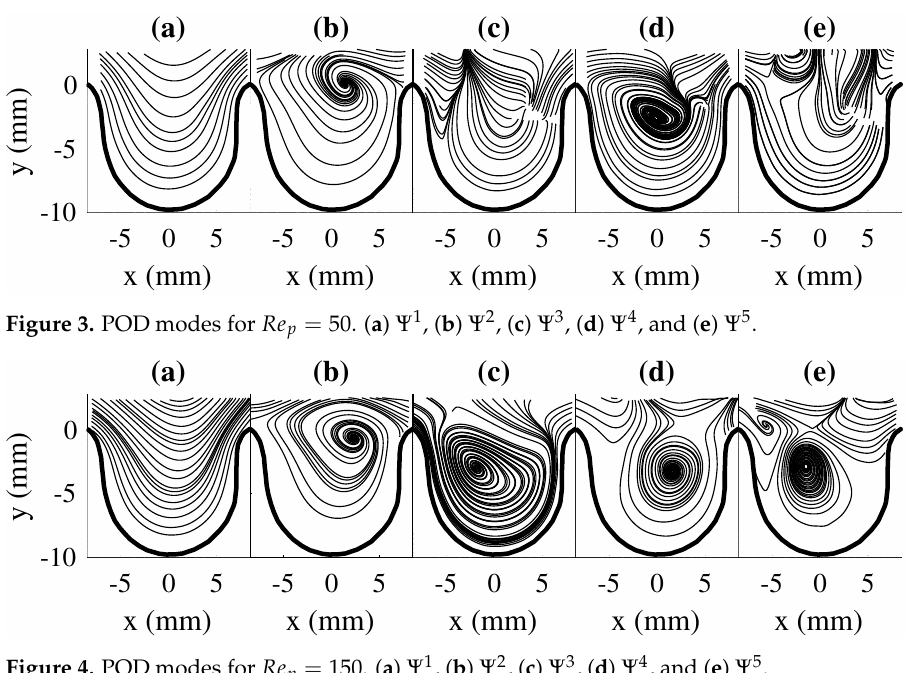
Figure 4. POD modes for Re p = 150. ( a ) Ψ 1 , ( b ) Ψ 2 , ( c ) Ψ 3 , ( d ) Ψ 4 , and ( e ) Ψ 5 .